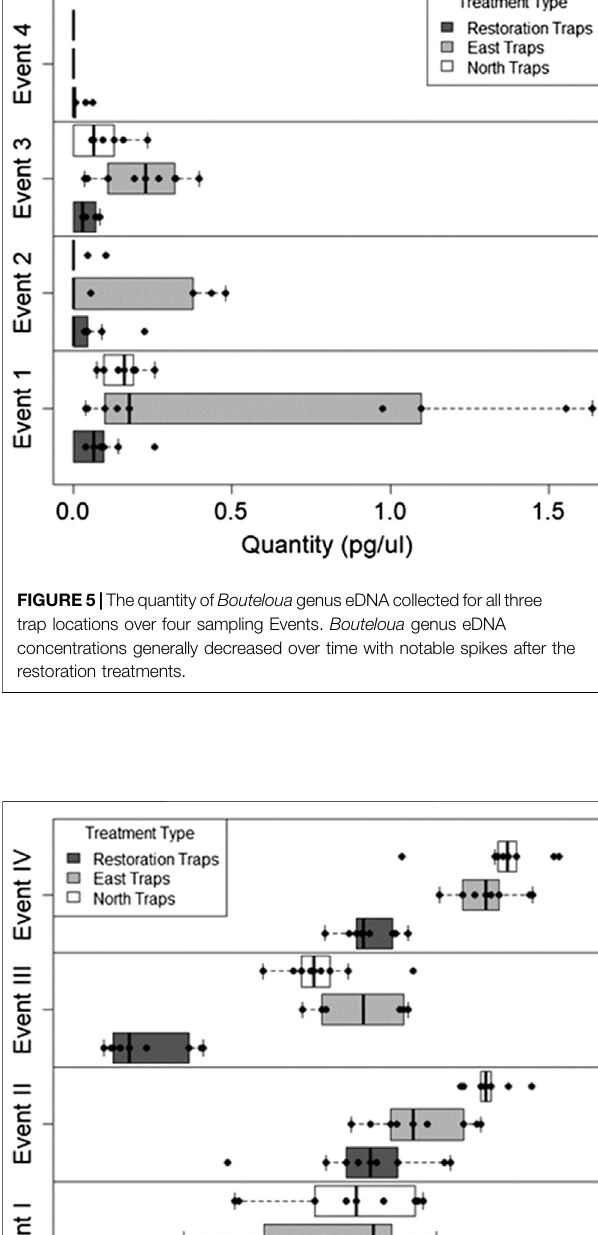
Frontiers in Environmental Science |